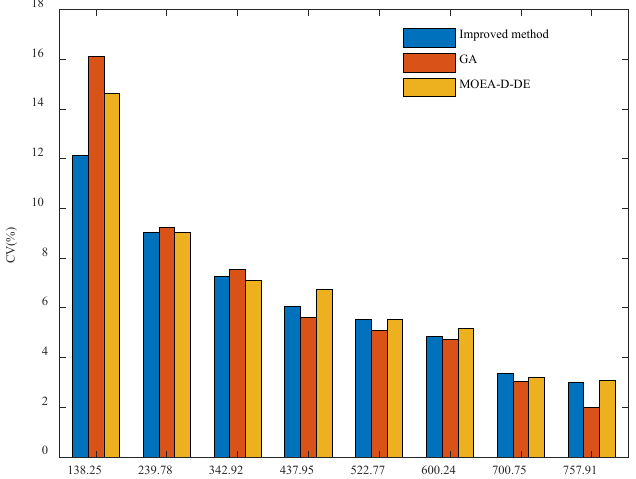
Figure 8. Comparison of the fertilization uniformities.